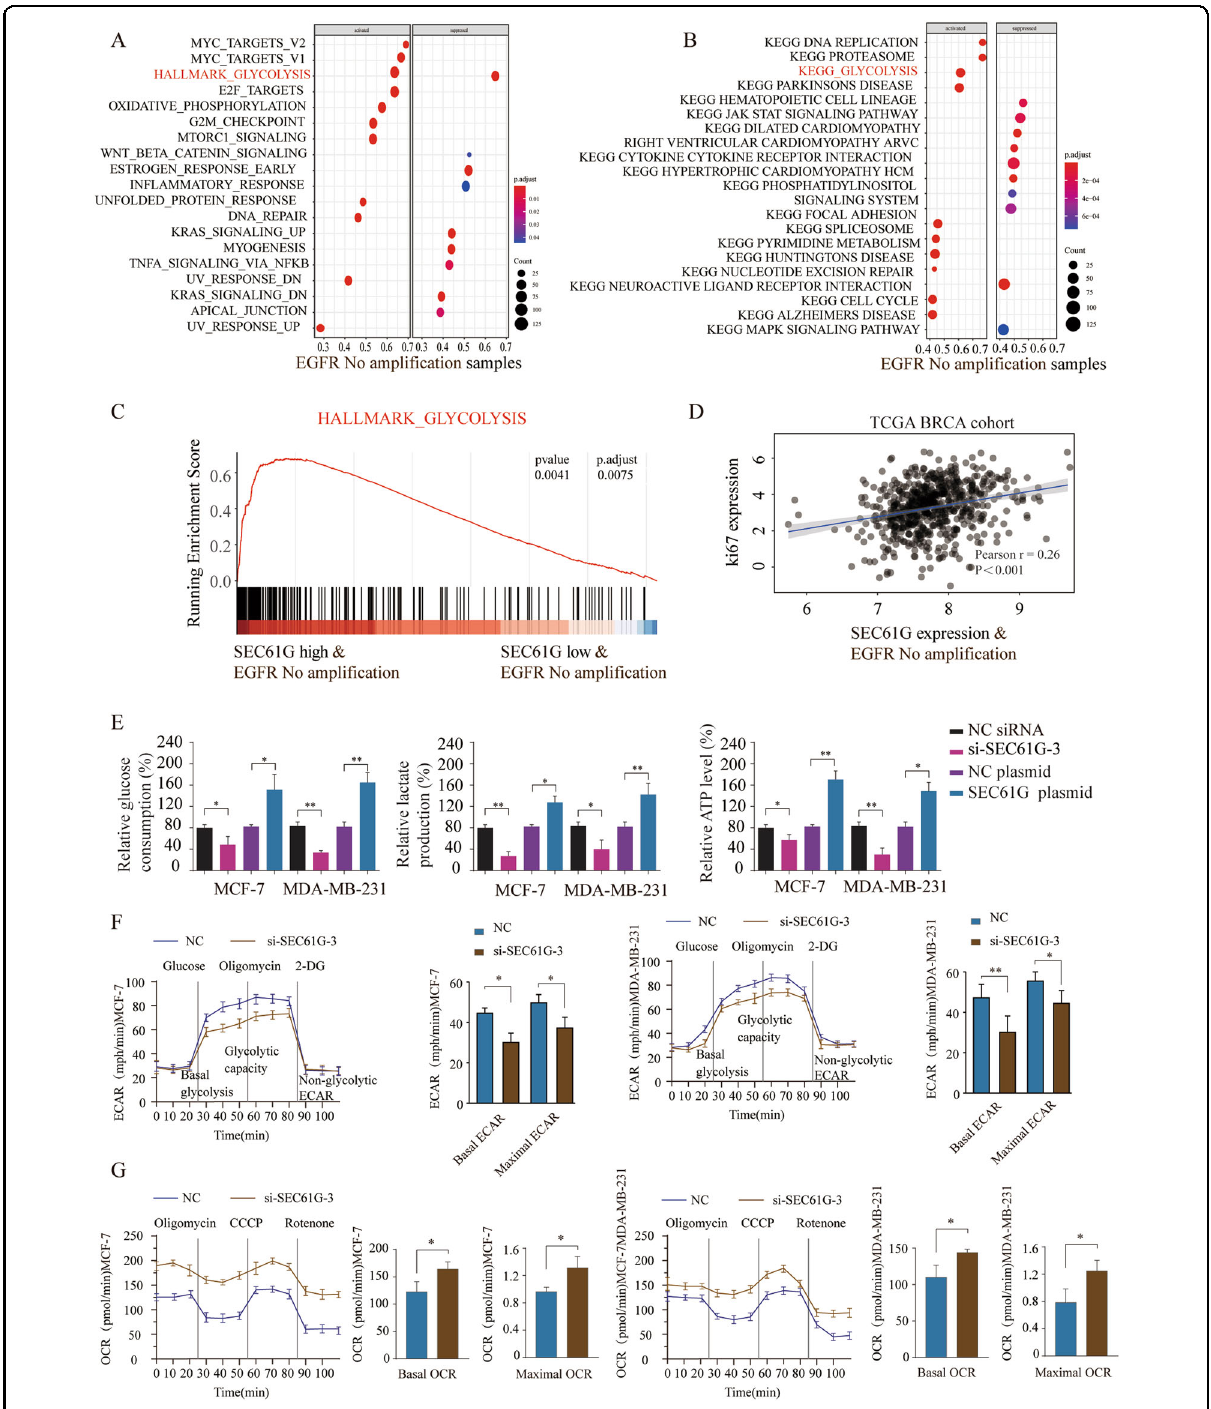
Fig. 5 SEC61G positively regulates glycolysis in breast cancer cells. A Gene Ontology analysis ( P < 0.001 FDR corrected) and B KEGG pathway enrichment analysis of the top 500 genes with high SEC61G expression in breast cancer cohort from TCGA database. C GSEA analysis of the relationship between SEC61G expression and glycolysis signaling. D Pearson analysis the correlation between SEC61G expression and Ki-67 expression in TCGA BRCA cohort. E MCF-7 or MDA-MB-231 cells were transfected with NC siRNA, si-SEC61G-3, NC plasmid, or SEC61G plasmid. The relative consumption of glucose, lactate production, and ATP levels in MCF7 or MDA-MB-231cells were analyzed. F , G MCF-7 or MDA-MB-231 cells were analyzed by Seahorse XP 96. Representative traces of the extracellular acidi fi cation rates (ECARs) and the oxygen consumption rates (OCRs) were shown respectively. The following compounds were injected into the assay microchambers as indicated: Glucose, oligomycin, carbonyl cyanide-4-(tri fl uoromethoxy) phenylhydrazone (CCCP), Rotenone, 2-deoxy glucose (2DG). Each data point is the mean±SD of four technical replicates. * P < 0.05, ** P <